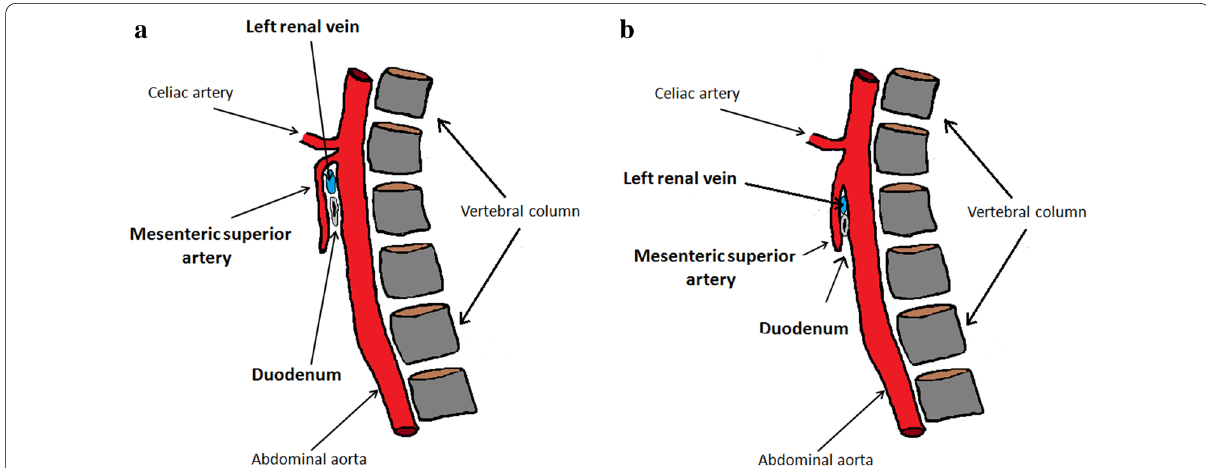
Fig. 6 NCS. Scheme summarizing that describes the relationships between the aorto-mesenteric angle, left renal vein, and duodenum. a Healthy patient with regular aorto-mesenteric angle. b Aorto-mesenteric angle lower than 22° which causes compression of the left renal